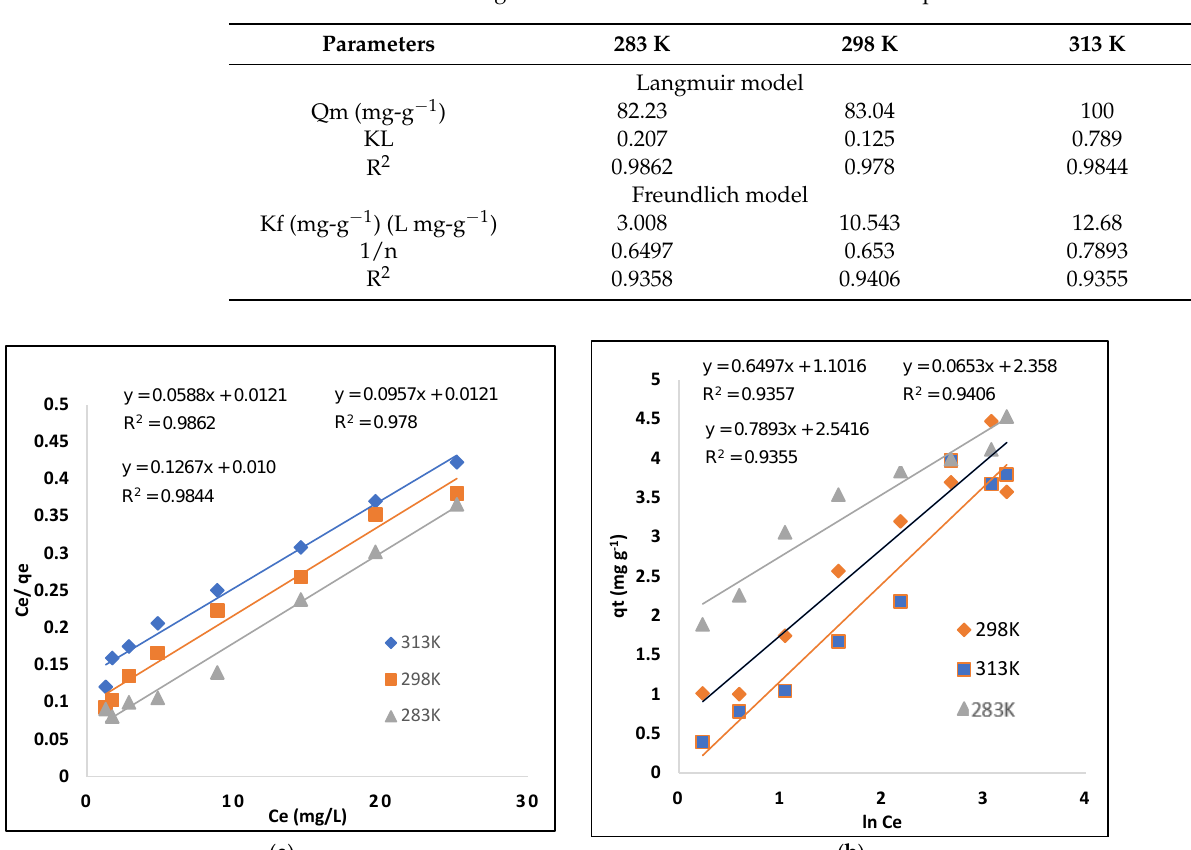
Table 3. Parameters of Langmuir and Freundlich models for the adsorption of AB-234 on the MIP.